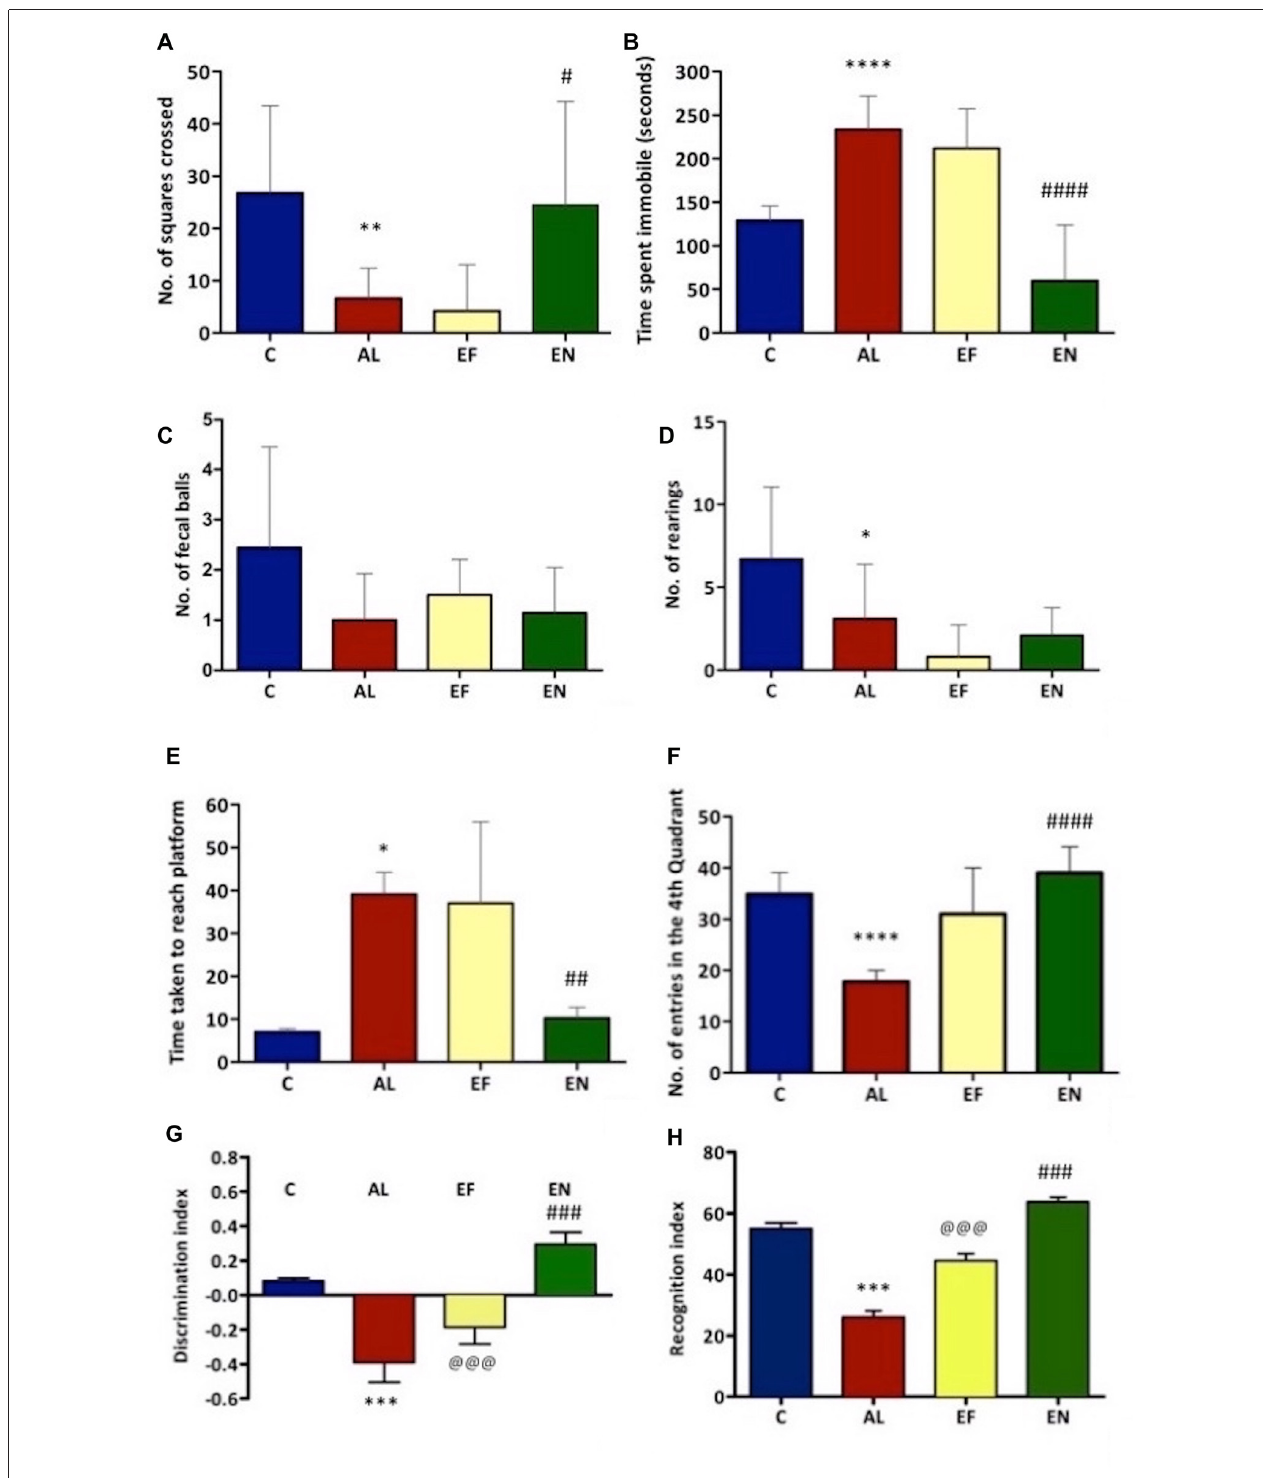
FIGURE 2 | Effect of AlCl 3 induction, free EGCG and nanoEGCG treatment on (A) Open field test—squares explored, (B) total time immobile, (C) fecal pellets, (D) rearing, (E) Morris water maze—the time taken to escape to the platform, (F) time spent in the target quadrant, (G) Novel object recognition test—discrimination index and (H) recognition index. Abbreviations: C, control; AL, AlCl 3 induced Alzheimeric rats; EF, free EGCG treated AlCl 3 induced Alzheimeric rats; EN, nanoEGCG treated